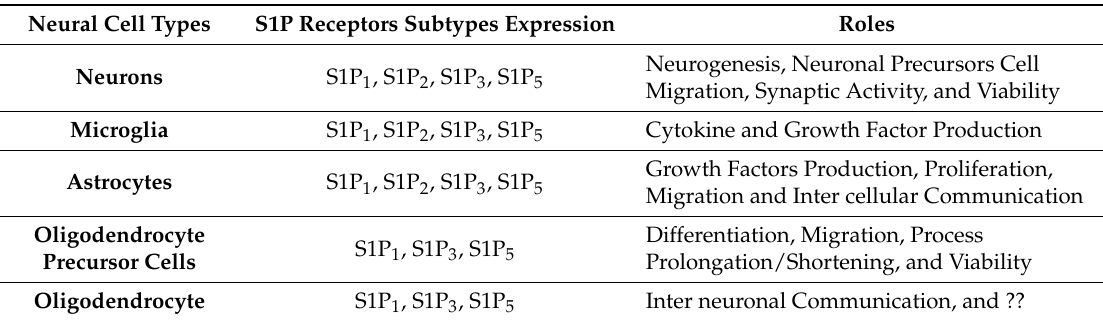
Table 2. S1P expression and roles in the neural